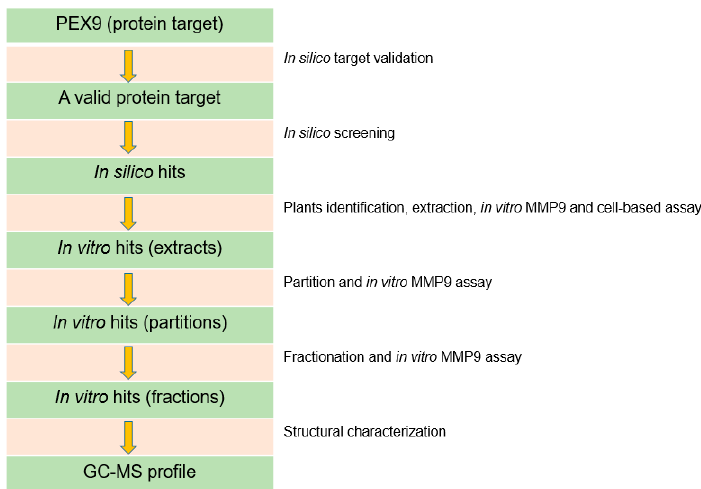
Figure 1. The flow chart of the studies in bioguided fractionation of local plants to identify MMP9 inhibitors and breast cancer cytotoxic agents.